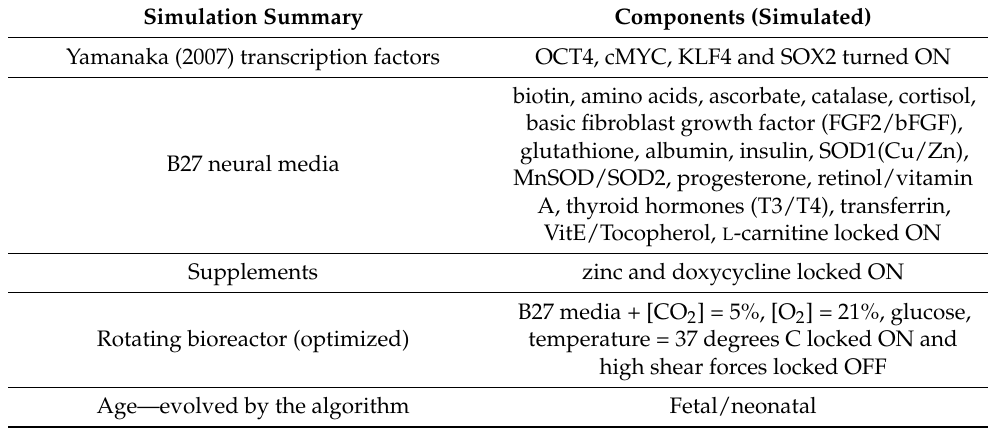
Table 1. Unguided aiPSC to artificially induced whole-brain organoids (aiWBO) simulation program. Simulation